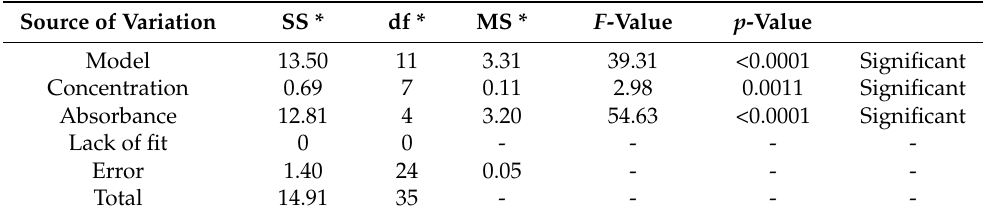
Table 6. ANOVA table of the minimum concentration for eradication of biofilm for MWCNTs on the investigated strains.